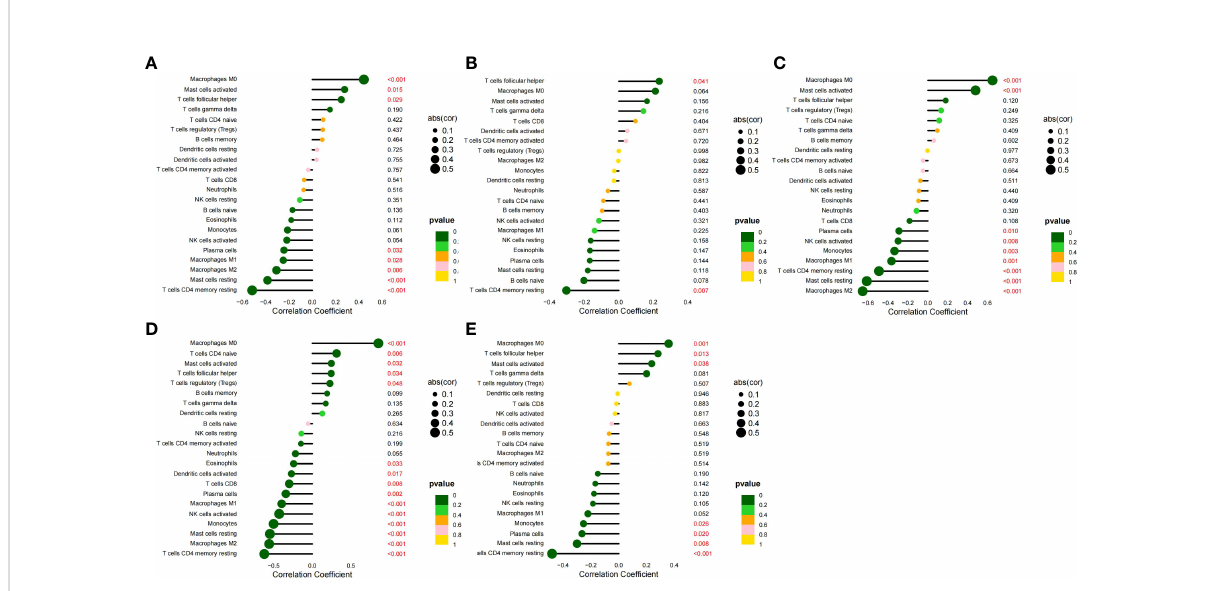
FIGURE 11 Correlation between fi ve HGs and IICs in AS. (A) Correlation between CCR1 and IICs. (B) Correlation between CD163 and IICs. (C) Correlation between IL1RN and IICs. (D) Correlation between MMP9 and IICs. (E) Correlation between SIGLEC1 and IICs.